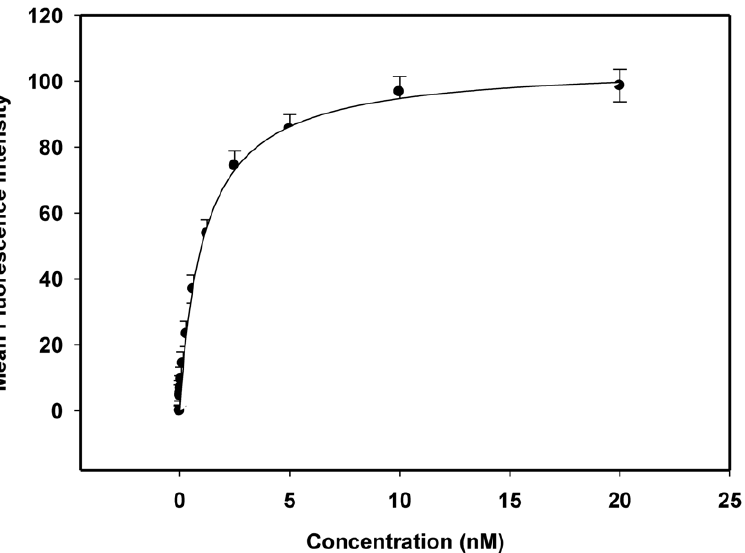
Figure 5. Binding curve of KC2D8 aptamer with DLD-1 cells. Cells were incubated with varying concentrations of Biotin-labeled aptamer in duplicate. The florescence signal was detected with streptavidin-PE-cy5.5. The mean fluorescence intensity of the unselected library (background binding) at each concentration was subtracted from the mean fluorescence intensity of the corresponding aptamer. The actual fluorescence intensity was fitted into Sigmaplot to determine the apparent Kd.